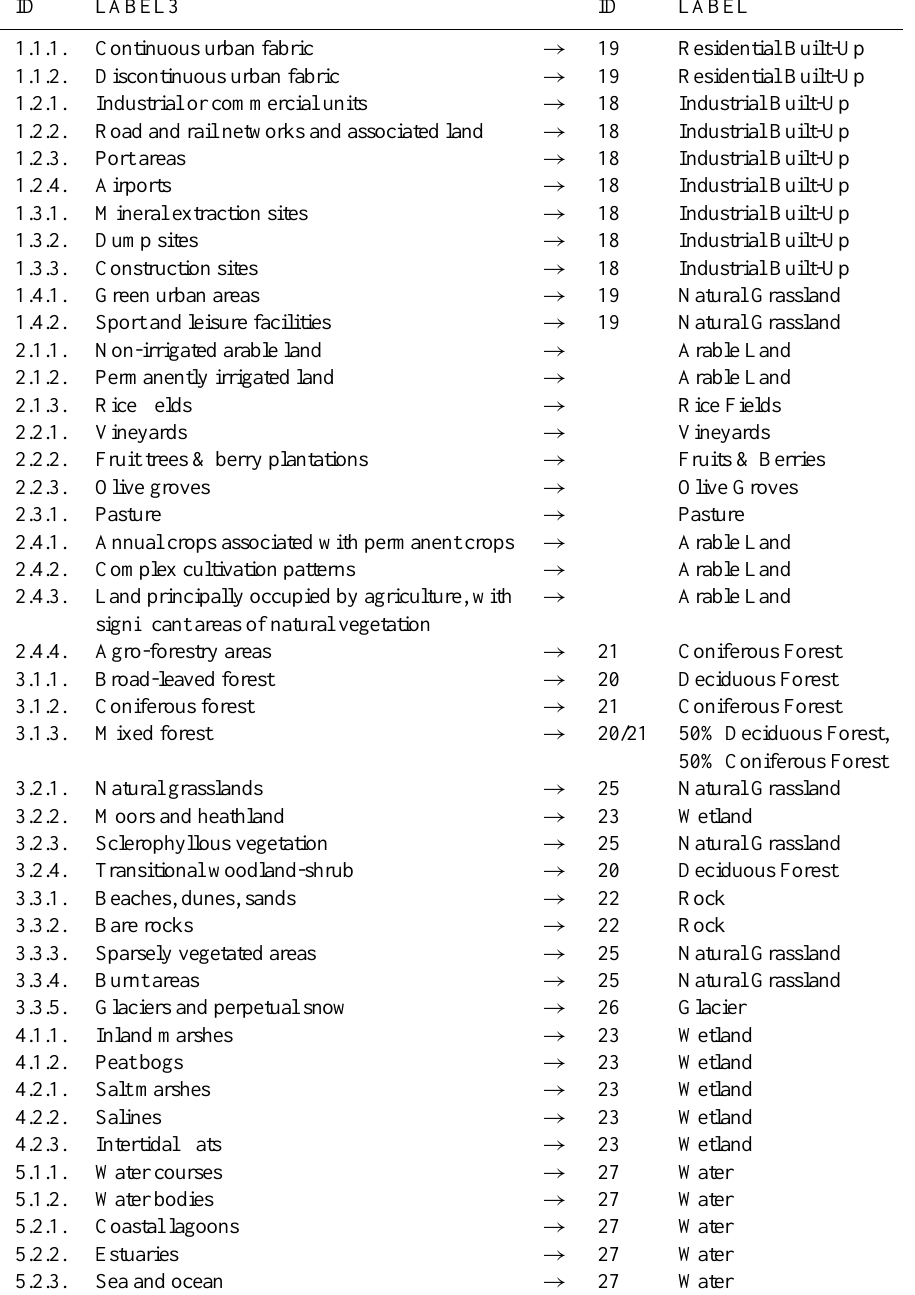
Table 2. Transformation of CORINE Land Cover 2000 into the PROMET